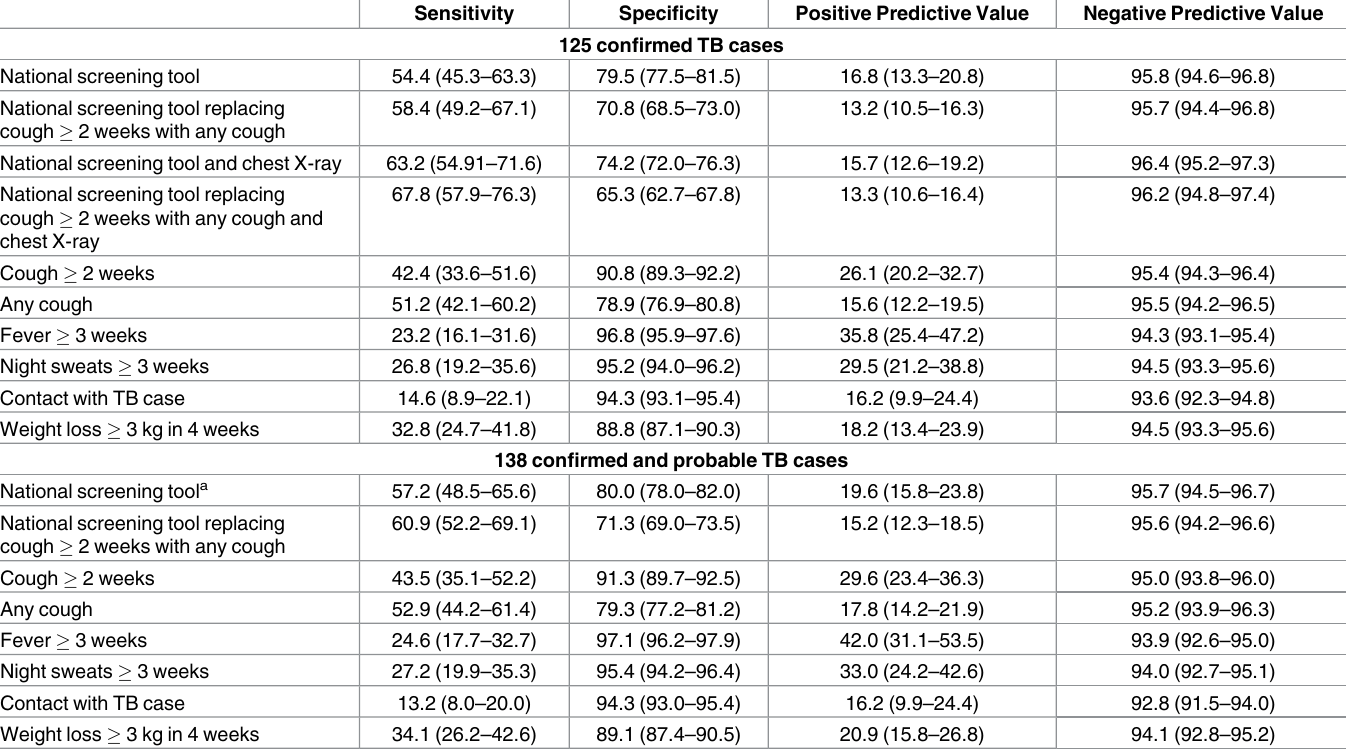
Table 3. Operating Characteristics of the National Screening Tool, by Screening Tool